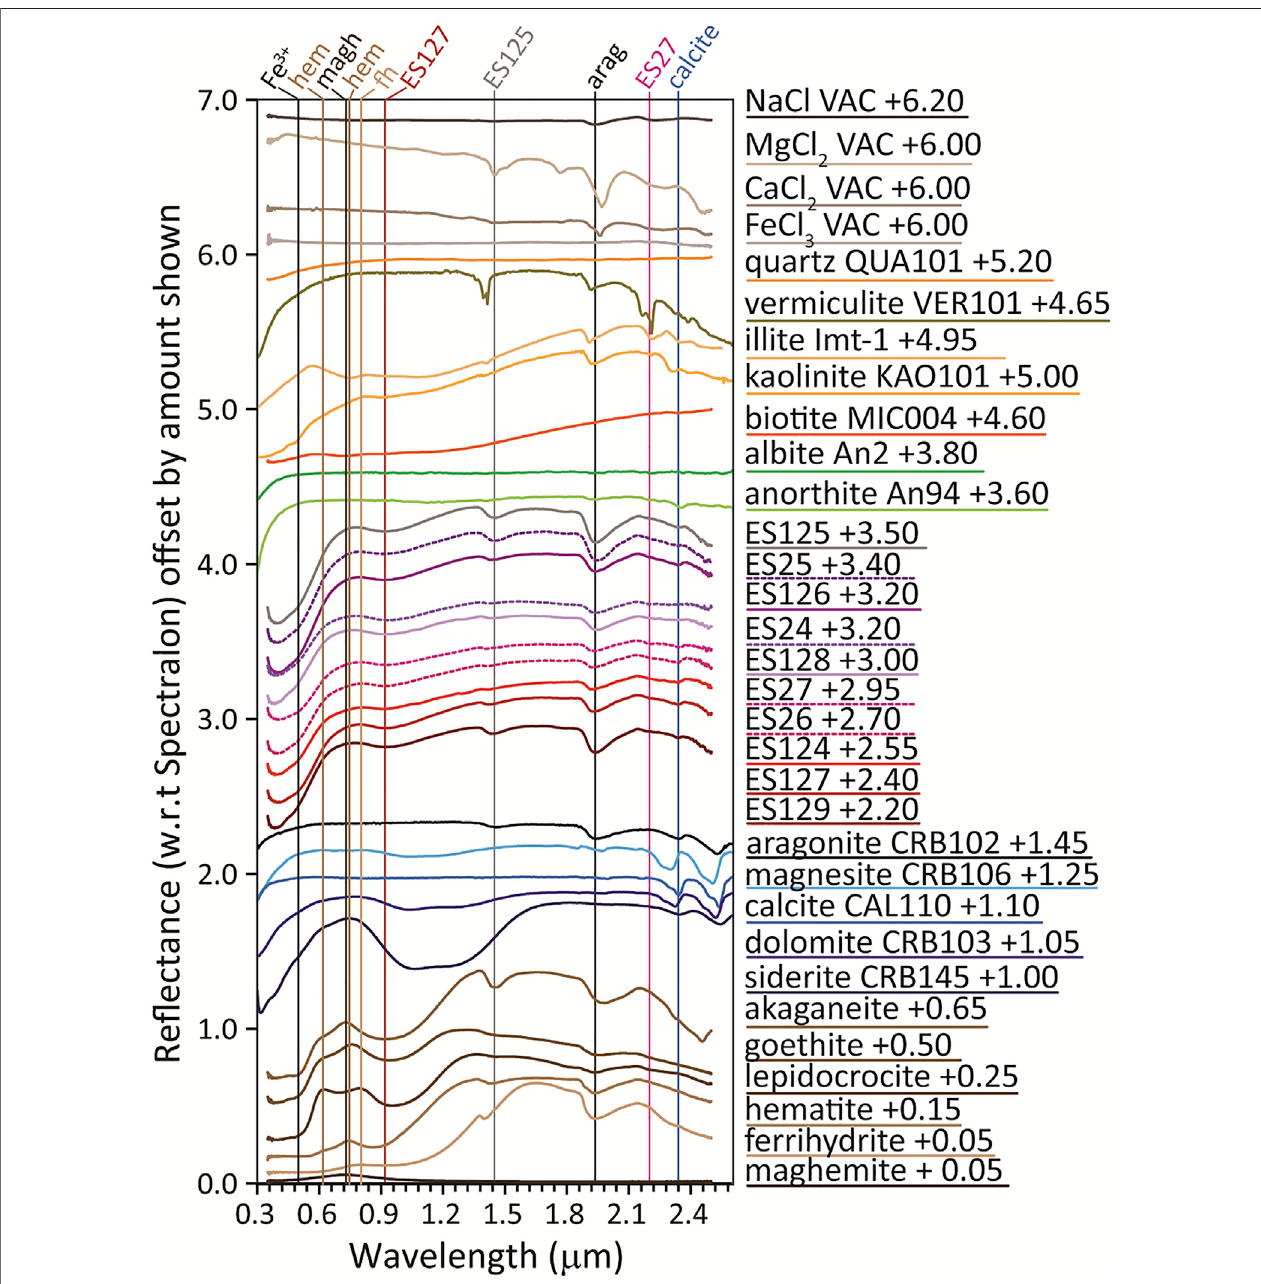
FIGURE 6 | VNIR spectra of Blood Falls samples along with reference spectra. (Hydr)oxide spectra are from Sklute et al., 2018b), chloride “ VAC ” spectra are from Sklute et al. (2018a), all other spectra except illite (which is RELAB sample c1jb782) are downloaded from the Center for Terrestrial and Planetary Exploration (C-TAPE) public archive 3